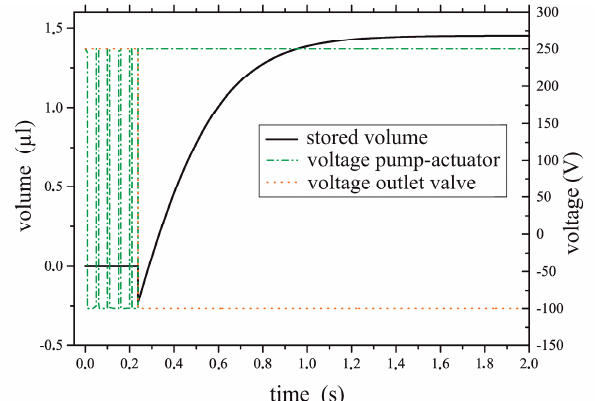
Figure 10. The voltage of the pump actuator can be seen in the green dash-dotted line and the voltage of the valve in the dotted line. After a certain time the valve is opened and the volume is released, (see corresponding line). The dispensed volume rises with a capacitive charge